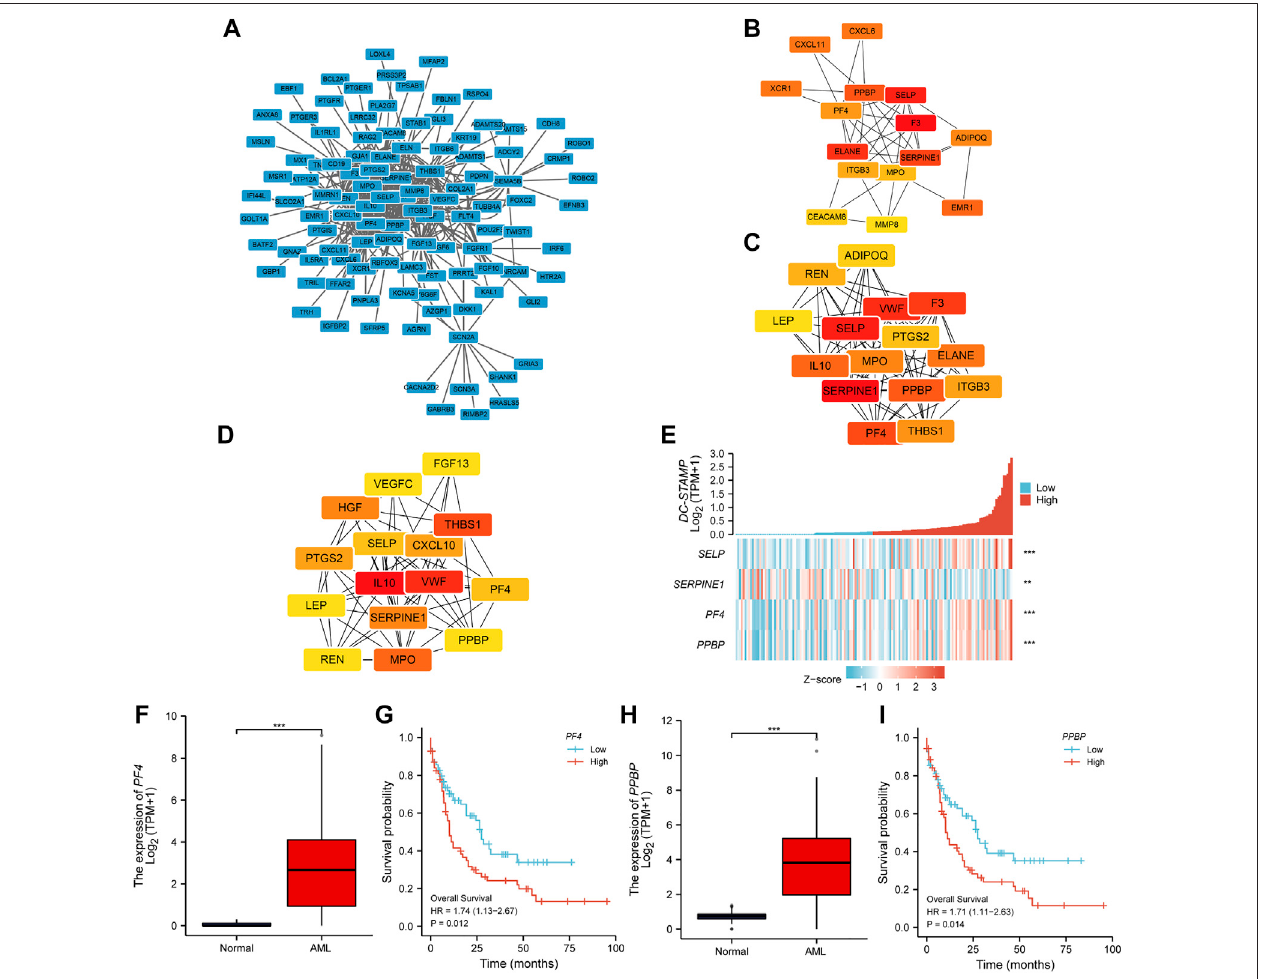
FIGURE 5 | PPI network construction and clinical signi fi cance of hub genes. (A) The PPI network of 358 encoding DEGs. (B – D) Top 15 hub genes were selected respectively by (B) MNC, (C) DMNC, and (D) MCC. (E) Association of DC-STAMP withfour hub genes( SELP , SFRPINE1 , PF4 , and PPBP ). (F) Expression levels of PF4 inAML( n =173)andnormalsubjects( n =70). (G) DifferentOSbetweenhigh-andlow- PF4 expressionlevelsshownbyKMcurves. (H) Expressionlevelsof PPBP inAML ( n = 173) and normal subjects ( n = 70). (I) Different OS between high- and low- PPBP expression levels shown by KM curves. (* p < 0.05, ** p < 0.01, *** p <